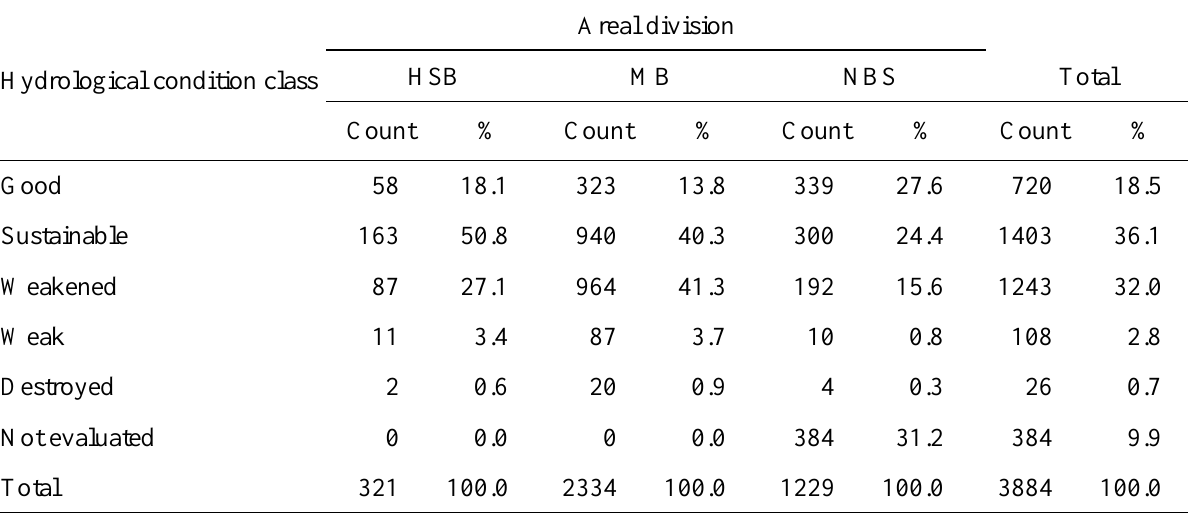
Table 1. Hydrological condition of undrained peatland patches (> 50 ha) according to the Finnish Environment Institute’s air photo